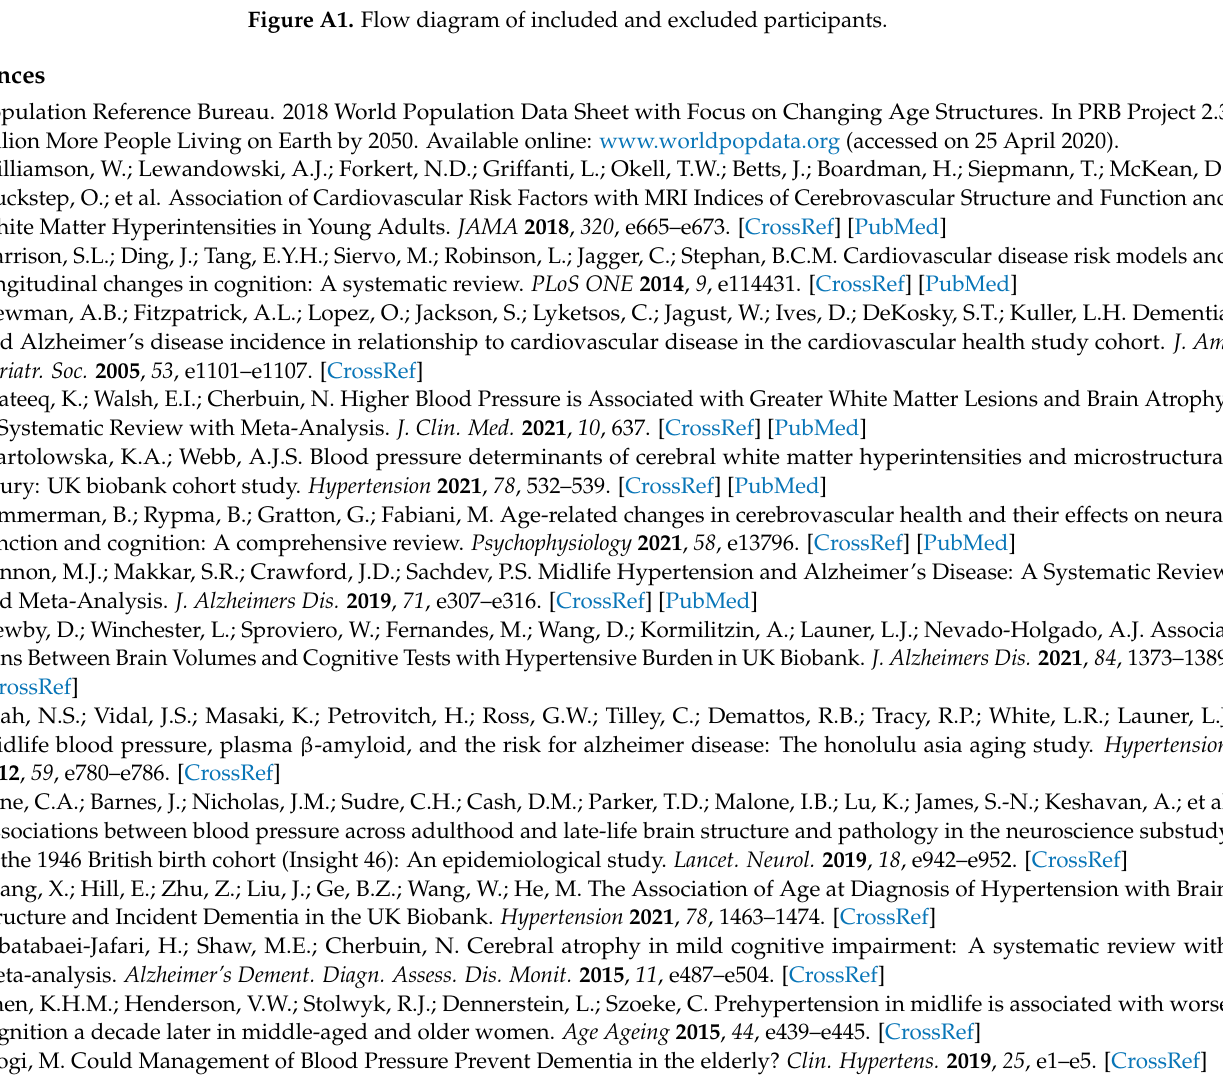
Figure A1. Flow diagram of included and excluded